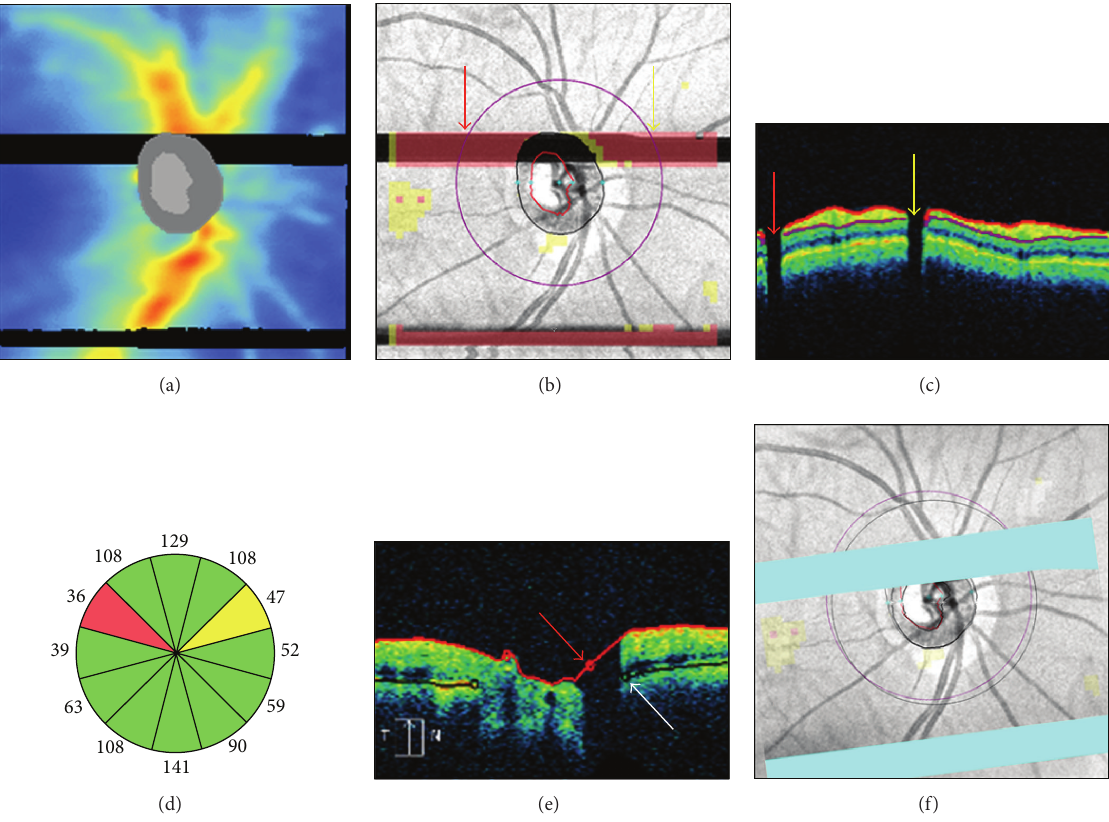
Figure 4: Blink artifacts. In a Cirrus-HD OCT right optic disc scan, two blinks produced two well-demarcated rectangular areas of missing data and red “superpixels” spanning the entire width of the retinal nerve fiber layer (RNFL) thickness map (a) and the RNFL deviation map (b). The upper blink affected the scan circle in two regions, as seen on the circular tomogram by two characteristic vertical black shadows interrupting the retinal profile (c). Note the corresponding RNFL thinning with abnormal classification results in clock hours 2 and 10 (d). The upper blink also affected the accuracy of the superior optic disc and cup margins ((e) arrows), leading to superotemporal scan circle displacement